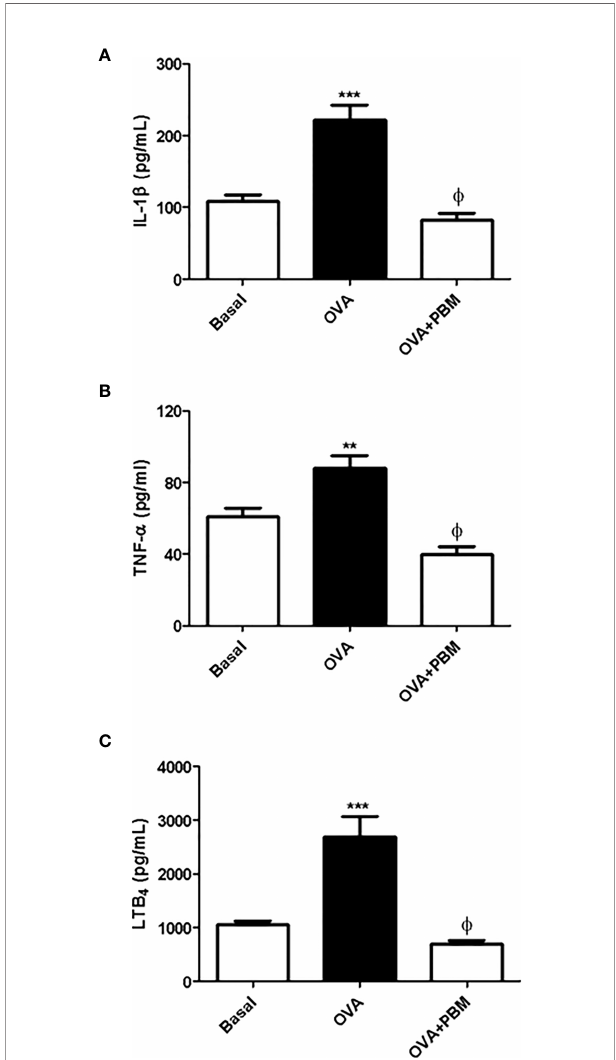
FIGURE 3 | Effect of photobiomodulation on BAL in fl ammatory mediators levels. Quanti fi cation of IL1- b (A) , TNF- a (B) , and LTB 4 (C) in BAL supernatant. Basal group, n = 5; OVA group, n = 7; PBM group, n = 5; OVA+ PBM, n = 8. Two independent sets of experiments were carried out. Data represent mean ± standard error (SEM). ** p < 0.01; *** p < 0.001 in relation to the Basal group. f p < 0.001 in relation to the OVA